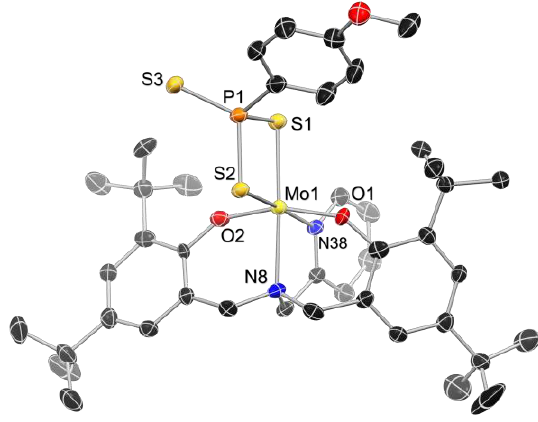
Figure 2. Molecular structure of 3 , with H-atoms and solvent molecules omitted. Displacement ellipsoids are drawn at the 50% probability level. Table 1. Selected bond lengths (Å ) and angles (°) for studied complexes.